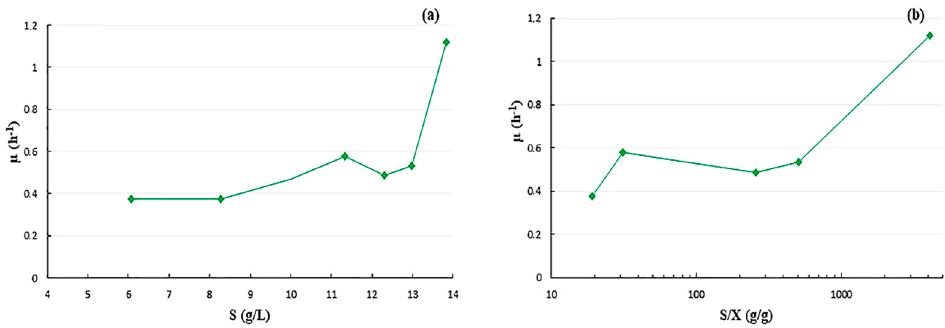
Figure 4. Specific growth rate µ as function of the glucose concentration S ( a ) and the glucose to biomass weight S/X ratio, expressed in logarithmic scale ( b ) during the fermentation process performed with pH control.